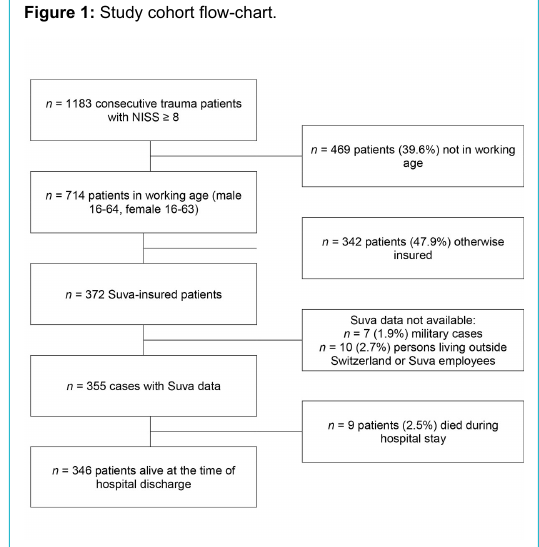
Figure 1: Study cohort